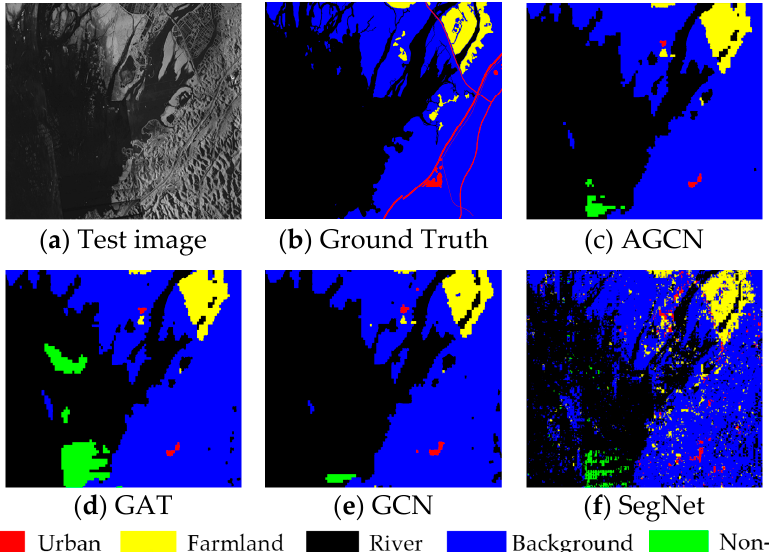
Figure 5. Segmentation results of four models on the Fangchenggang dataset. ( a ) Input image; ( b ) ground truth; ( c ) AGCN; ( d ) GAT; ( e ) GCN; ( f ) SegNet.